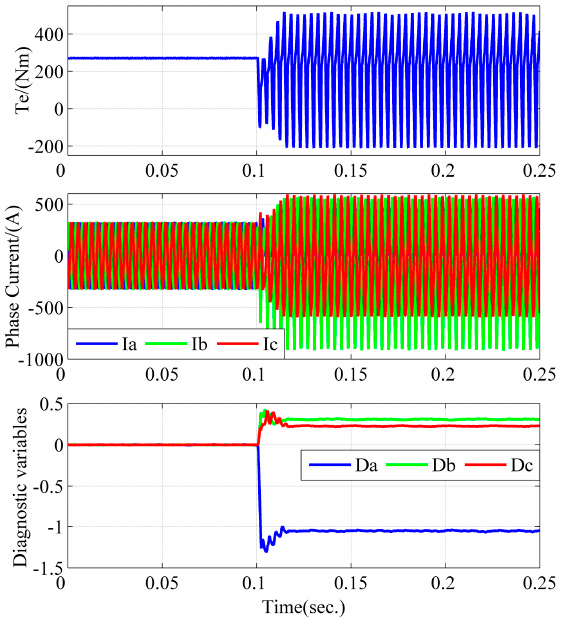
Figure 11. Diagnostic results at 2800 rpm/256 Nm.